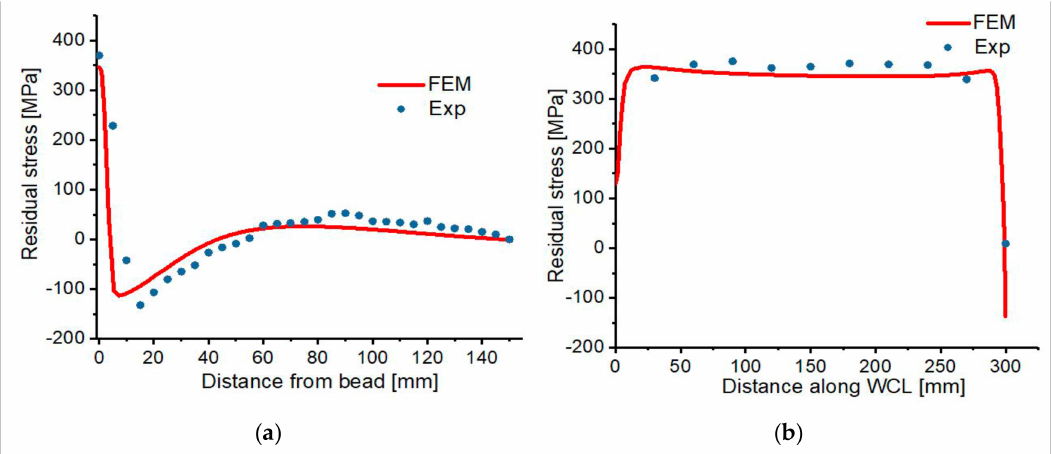
Figure 14. ( a ) Residual stresses in the transverse direction ( b ) residual stresses in the longitudinal